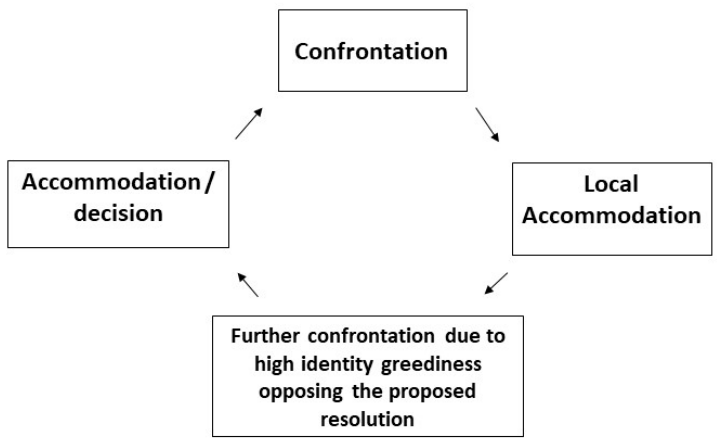
Figure 2. The Circular Model.